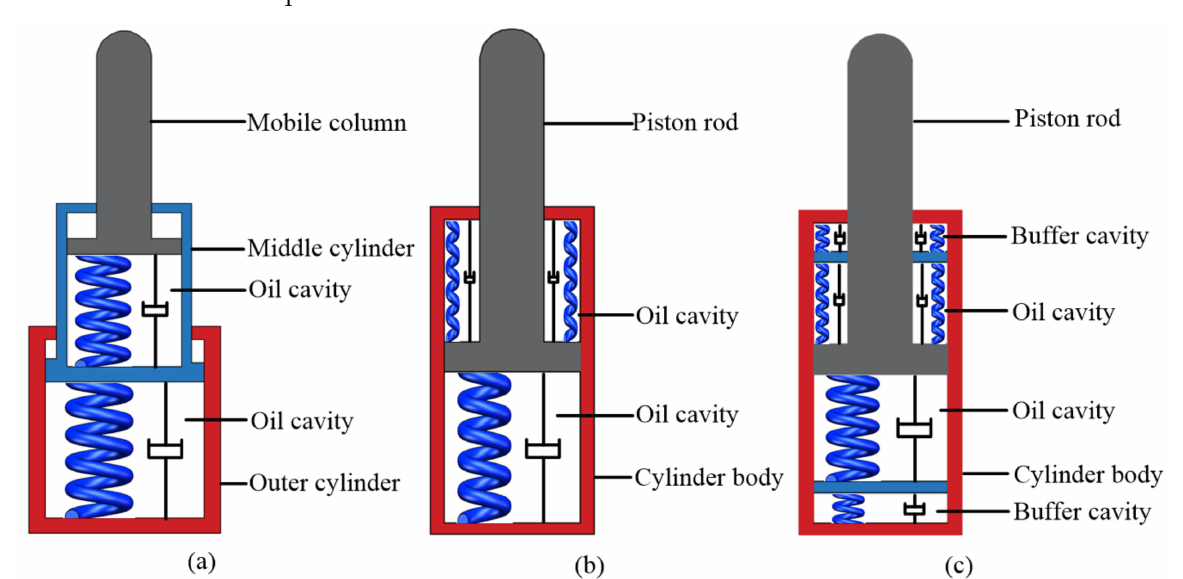
Figure 5. The equivalent schematic diagram: ( a ) column; ( b ) the traditional balance jack; ( c ) the novel balance jack with multi-adaptive